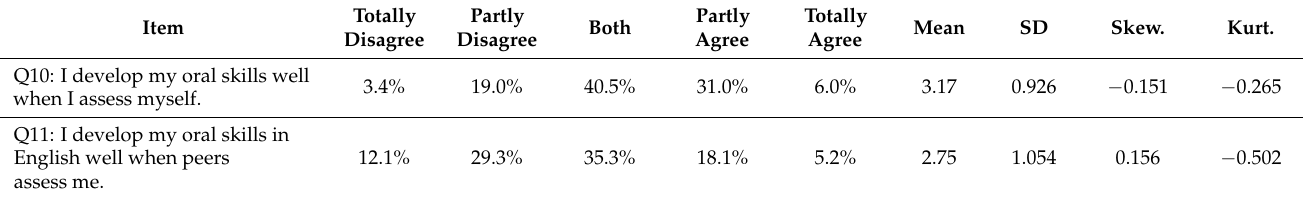
Table 8. Students’ perceived learning outcomes from self- and peer